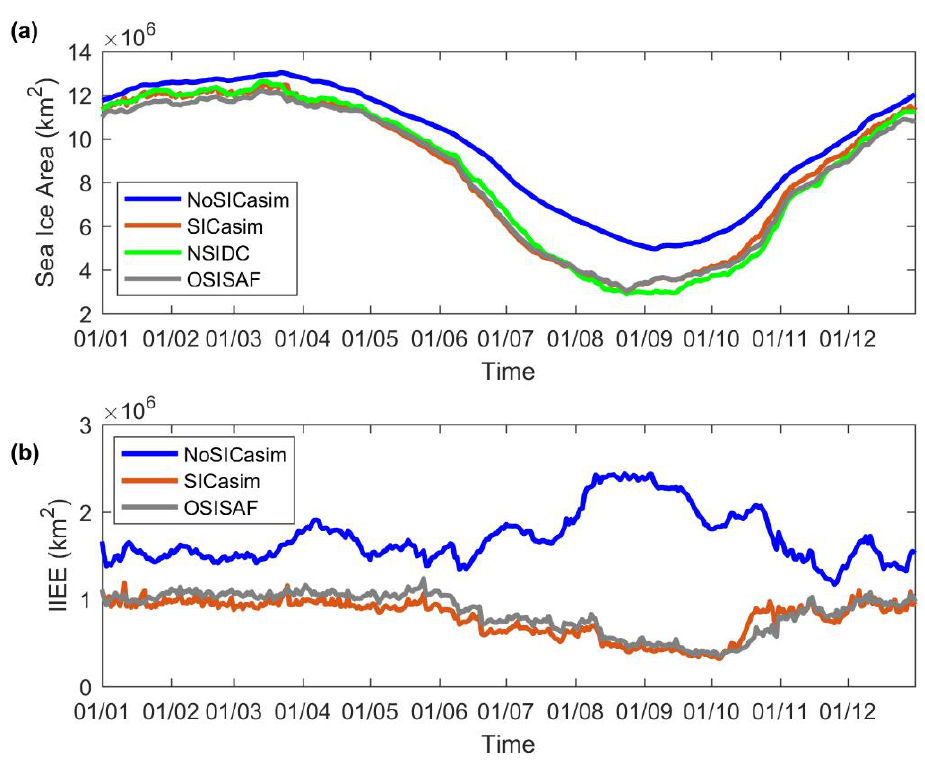
Figure 4. Sea ice area ( a ) and IIEE ( b ) time series in the Arctic region from 1 January to 31 December 2019. The experiments without and with data assimilation are shown in blue and orange, respectively. Sea ice areas of NSIDC and OSISAF are shown in green and gray, respectively. IIEEs between NSIDC and OSISAF are shown in gray.